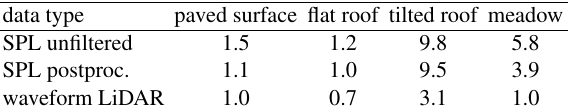
Table 1. Point cloud dispersion